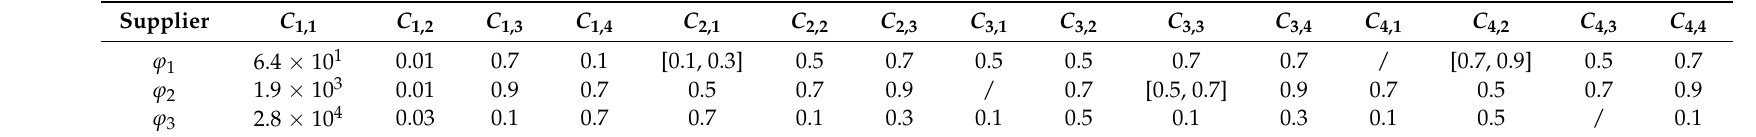
Table 1. The index values of three bearing cage suppliers.